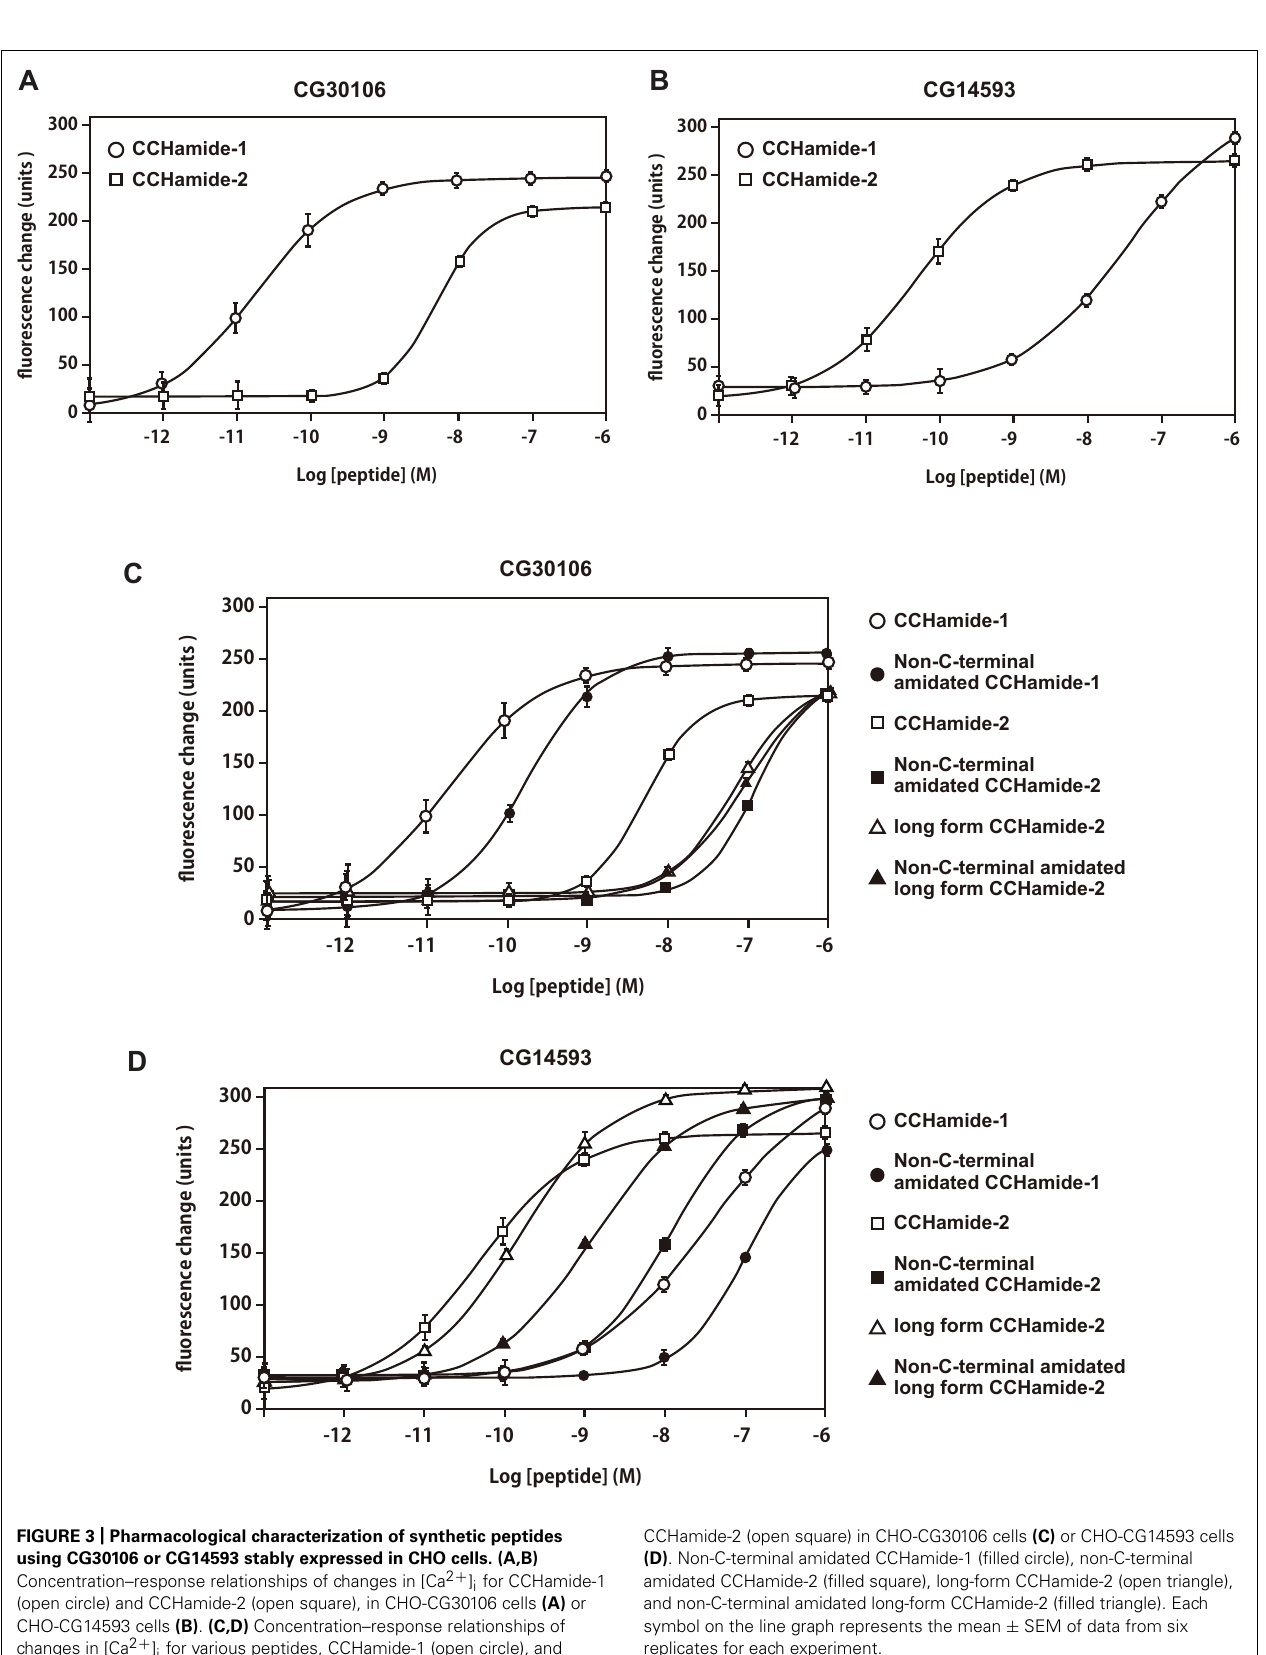
CCHamide-2 (open square) in CHO-CG30106 cells (C) or CHO-CG14593 cells (D) . Non-C-terminal amidated CCHamide-1 (filled circle), non-C-terminal amidated CCHamide-2 (filled square), long-form CCHamide-2 (open triangle), and non-C-terminal amidated long-form CCHamide-2 (filled triangle). Each symbol on the line graph represents the mean ± SEM of data from six replicates for each